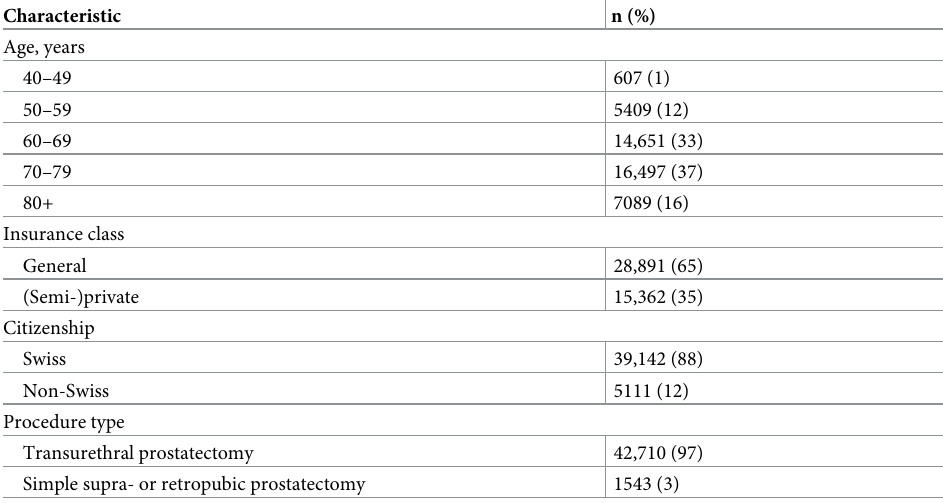
Table 1. Characteristics of 44,253 men aged � 40 years with prostate surgery from 2013 to